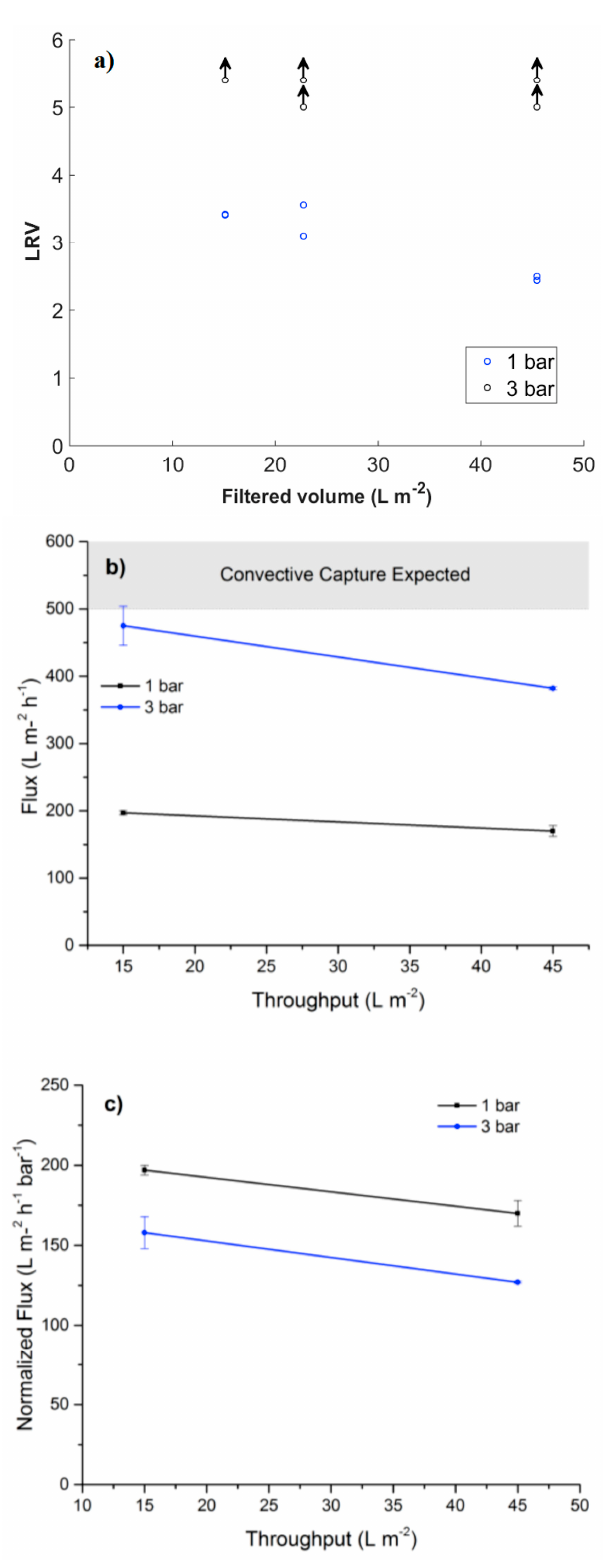
Figure 7. ( a ) Log reduction values (LRV) for filtration of Φ X174 bacteriophages at overhead pressures of 1 and 3 bar and a filter thickness of 9 µ m. Arrows indicate that the obtained values are below the limit of detection (LOD). ( b ) Flux values for the filter at 1 and 3 bars, area marked in gray indicates fluxes where simulations predict hydrodynamic capture, i.e., Pe ≥ 1; For the 28 nm Φ X174 bacteriophages ( c ) Normalized flux per bar highlighting the compaction effect of the